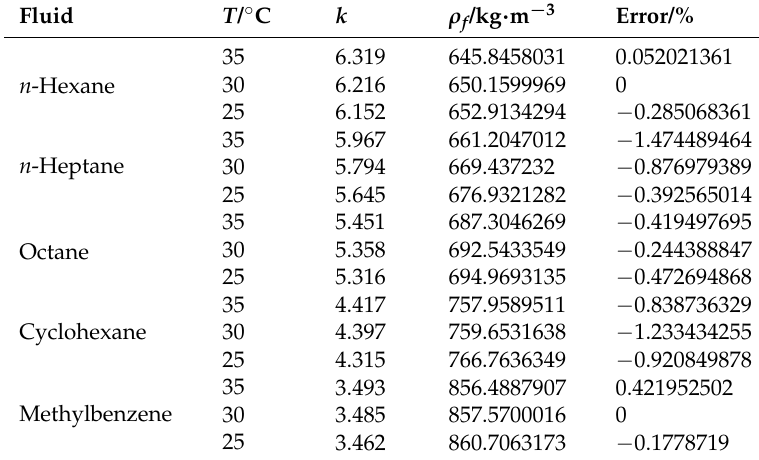
Figure 11. The measuring curves under double sided excitation. ( a ) The relationship curves of driving voltage and output voltage under double sided excitation; ( b ) The relationship curve between slope and fluid density under double sided excitation. Table 3. The density measurement results by the slope method under double sidedexcitation.